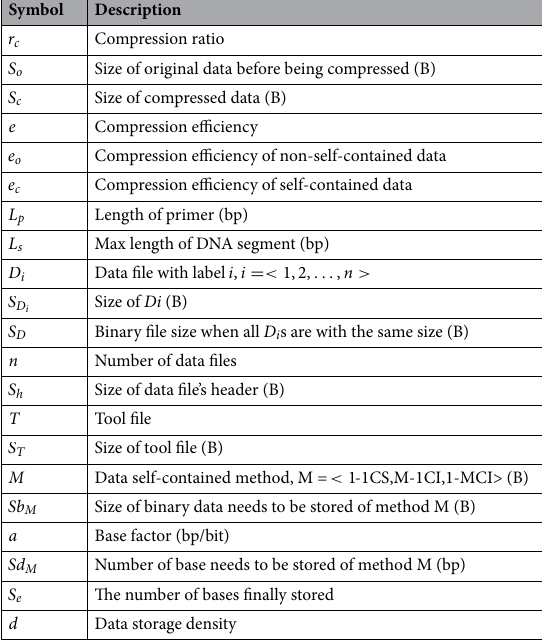
Table 3. Symbol description: Explanation of symbols to be